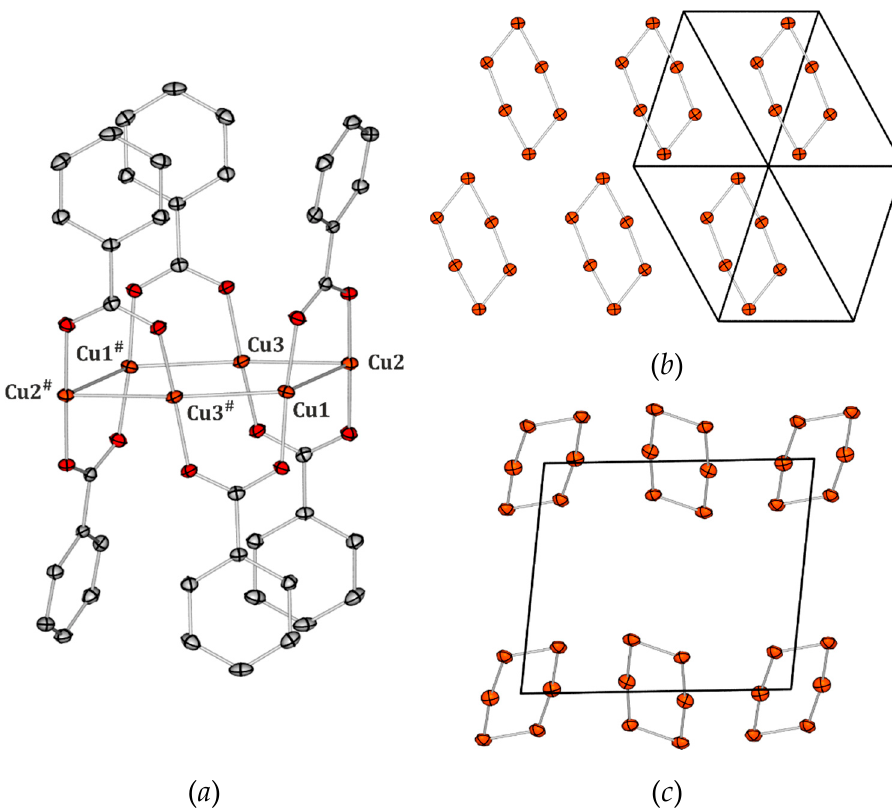
Figure 2. ( a ) Molecular structure of the Cu 6 complex at 90 K (atomic thermal motion is represented as ellipsoids drawn at a 50% probability level; hydrogen atoms have been removed for clarity; (#) symmetry operation: − x + 1, − y + 1, − z + 1). ( b , c ) Packing of the Cu 6 molecules at 90 K ( b ) and 290 K ( c ) (only copper cores are shown; ellipsoids drawn at 90% and 50%, respectively; panel (cid:2) (cid:3) ( b )—view along 111 direction, panel ( c )—view along [ 001 ] direction). Table 2. Selected bond distances describing the metal cores’ geometries in the Cu 6 crystal structures at different temperatures. Temperature, T /K Bond Distance, d /Å 290